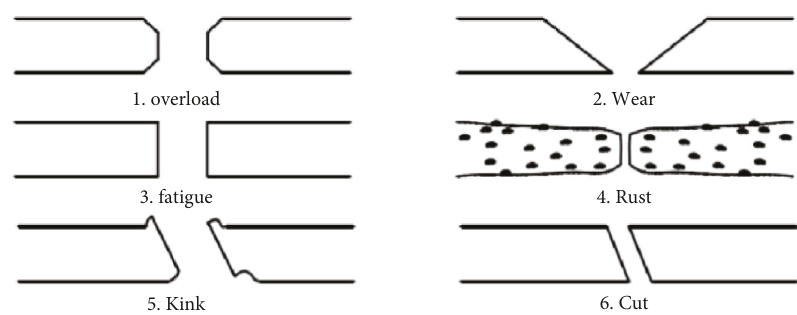
Figure 2: Types of LF